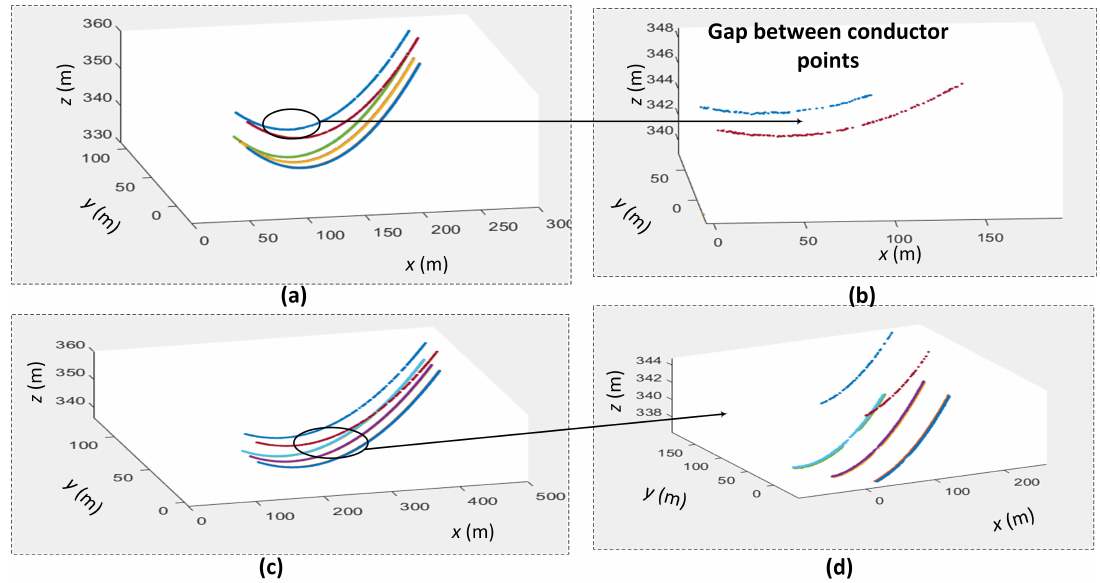
Figure 12. Extraction of individual conductors in Maindample (MDP) site. In panel ( a ) the origin (0, 0) represents (4.081 × 10 5 , 5.9036 × 10 6 ), in panel ( b ) the origin (0, 0) represents (4.084 × 10 5 , 5.90368 × 10 6 ), in panel ( c ) the origin (0, 0) represents (4.086 × 10 5 , 5.90368 × 10 6 ) and in panel ( d ) the origin (0, 0) represents (4.087 × 10 5 , 5.90368 × 10 6 ).